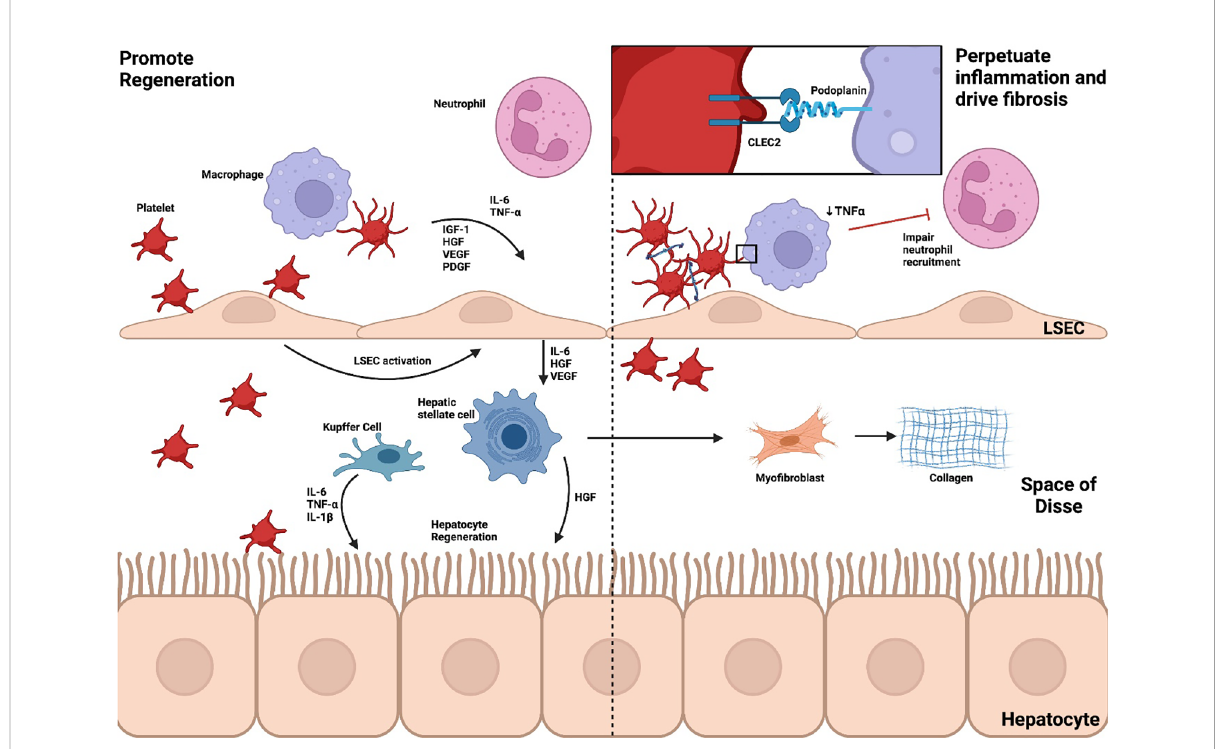
FIGURE 4 Platelets promote regeneration, perpetuate in fl ammation and drive fi brosis. The role of platelets in the resolution of in fl ammation is dualistic, potentiating immune-mediated damage, promoting regeneration and driving fi brosis. Through CLEC2, platelets activate LSECs to produce IL-6, TNF- a , HGF and VEGF which, in turn, triggers HGF release from HSCs to stimulate hepatocyte regeneration. HSC activation also leads to myo fi broblast differentiation and collagen synthesis. Neutrophils, critical to resolution of in fl ammation, are also recruited through cytokine and chemokine release. In an APAP model of ALF, however, platelet-macrophage interactions through CLEC2 reduce neutrophil recruitment and perpetuate in fl ammation. Liver sinusoidal endothelial cell, LSEC; Kupffer cell, KC; Hepatic stellate cell, HSC; interleukin, IL; Tumour necrosis factor alpha, TNF- a ; Insulin-like growth factor-1, IGF-1; Hepatocyte growth factor, HGF; Vascular endothelial growth factor, VEGF; Platelet- derived growth factor, PDGF; C-type lectin-like receptor 2, CLEC2; Acetaminophen, APAP; Acute liver failure, ALF